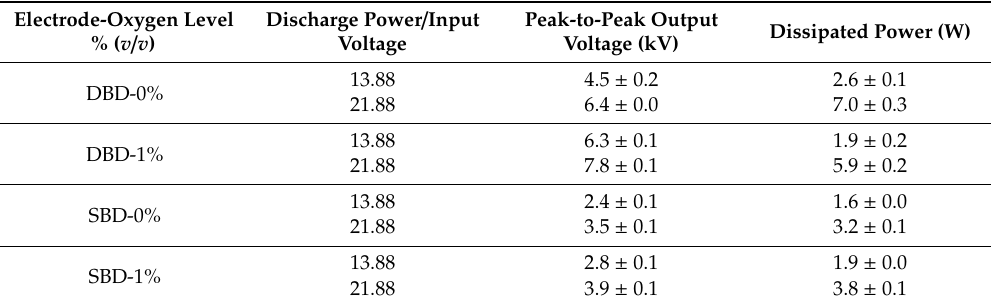
Table 1. Monitored output voltages (kV) and dissipated power (W) values as function of the applied CAP treatment conditions (i.e., electrode configuration, oxygen level of the gas flow, and discharge power / input